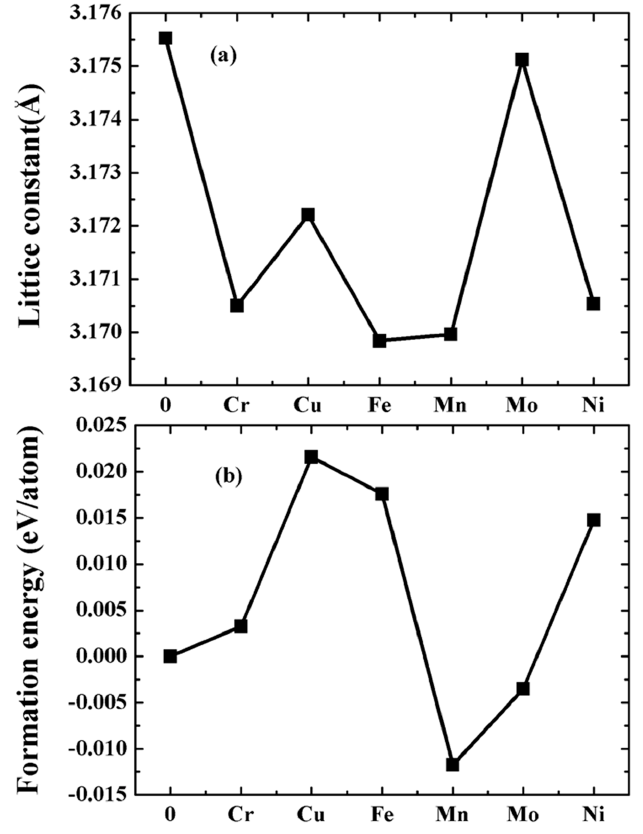
Figure 2. Equilibrium lattice constants ( a ) and formation energies ( b ) of pure W and the W-TM (TM = Cr, Cu, Fe, Mn, Mo and Ni, respectively) alloys. (TM = Cr, Cu, Fe, Mn, Mo and Ni, respectively)